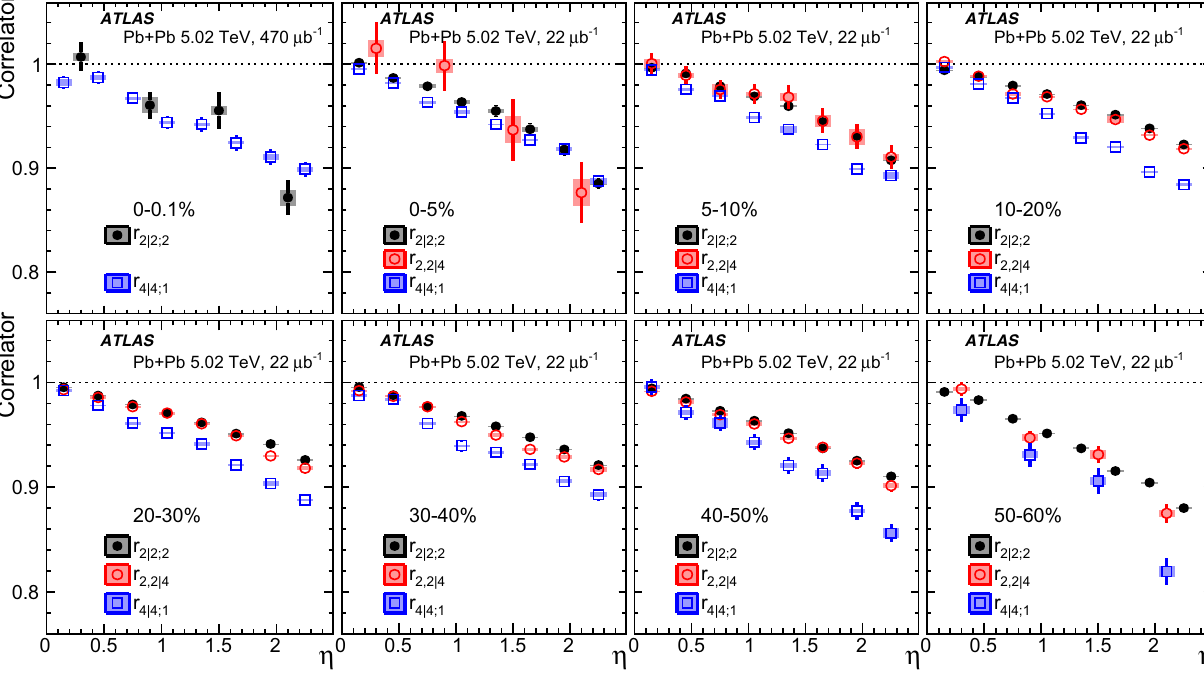
Fig. 22 Comparison of r 2 | 2 ; 2 , r 2 , 2 | 4 and r 4 | 4 ; 1 for several centrality intervals. The error bars and shaded boxes are statistical and systematic uncertainties, respectively. The data points in some centrality intervals are rebinned to reduce the